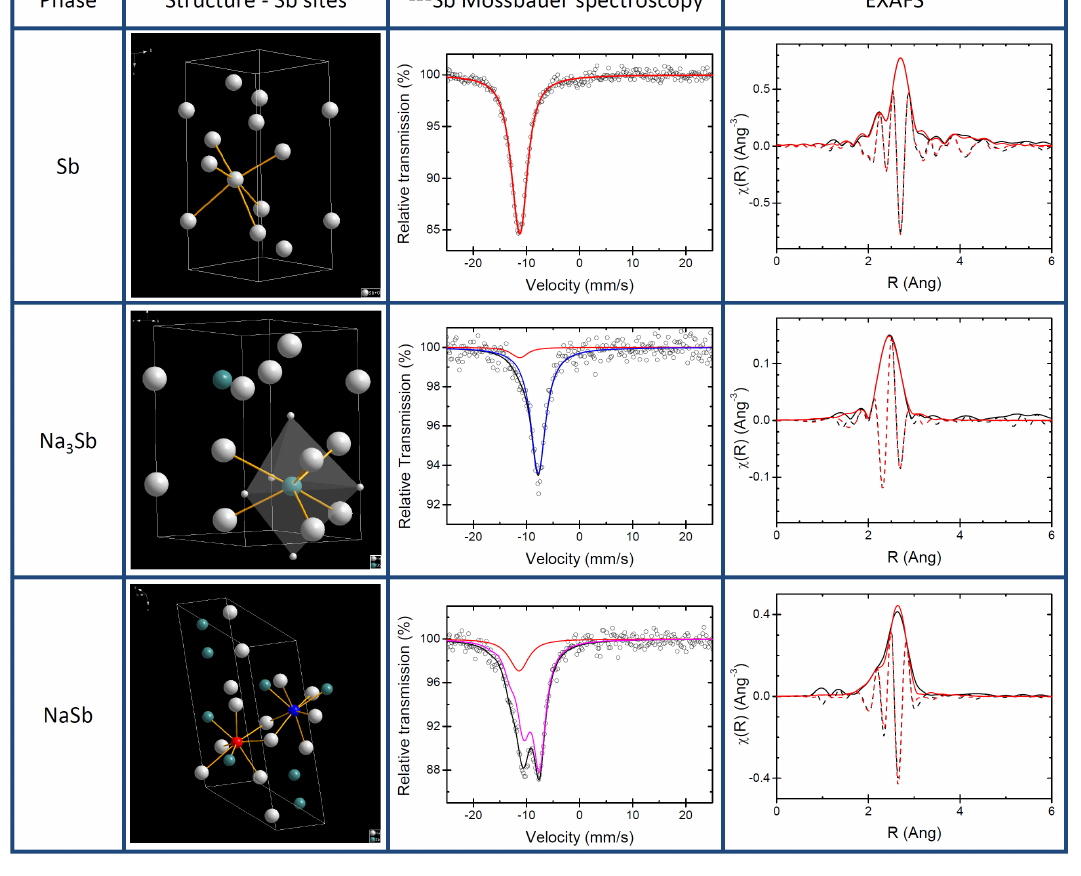
Figure 1. From ( left ) to ( right ): Local coordination of the Sb centres, 121 Sb Mössbauer and EXAFS spectra of reference compounds Sb, Na 3 Sb (Sb atoms in green) and NaSb (red and blue atoms identify the two Sb